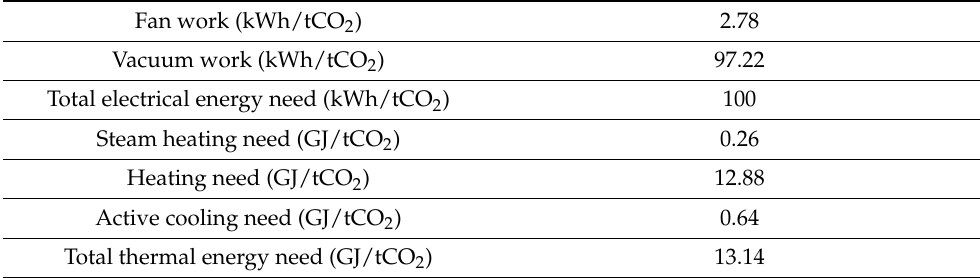
Table 5. Energy performances of the lab-scale